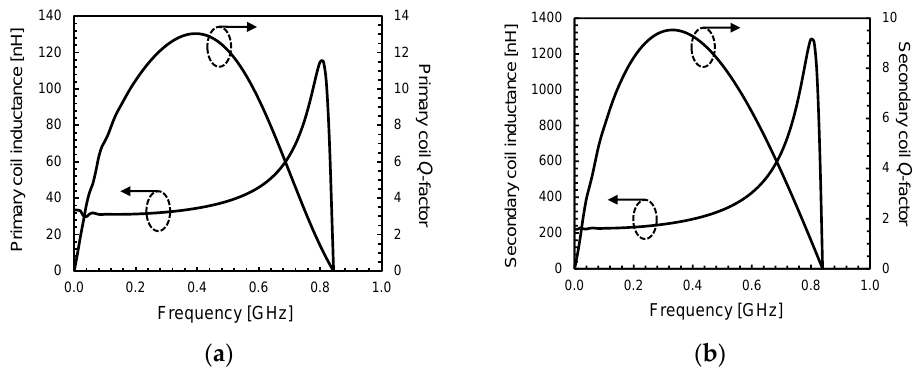
Figure 10. Transformer simulated performance: ( a ) primary winding; ( b ) secondary winding. Table 3. Electrical parameters of the polyimide isolation transformer at 250 MHz.